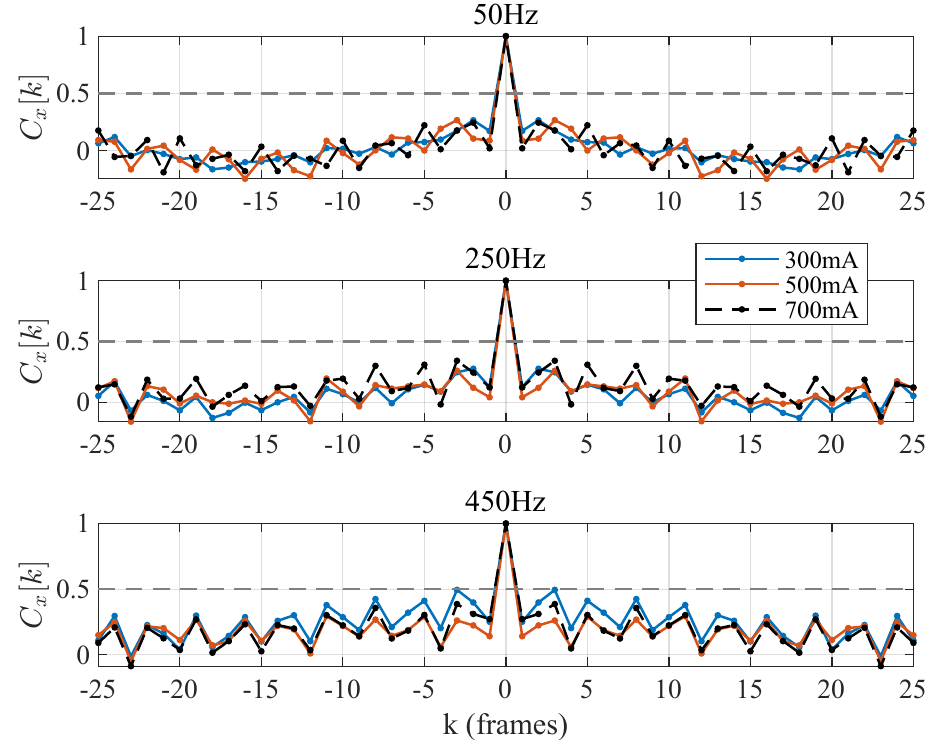
Figure 8. ACF of harmonics power for different